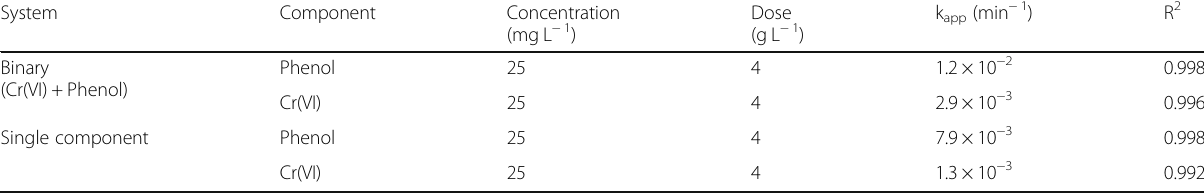
Table 3 Kinetic parameters of simultaneous oxidation and reduction of phenol and Cr(VI), respectively, by Photo-Zn-Bent hybrid in single and binary component